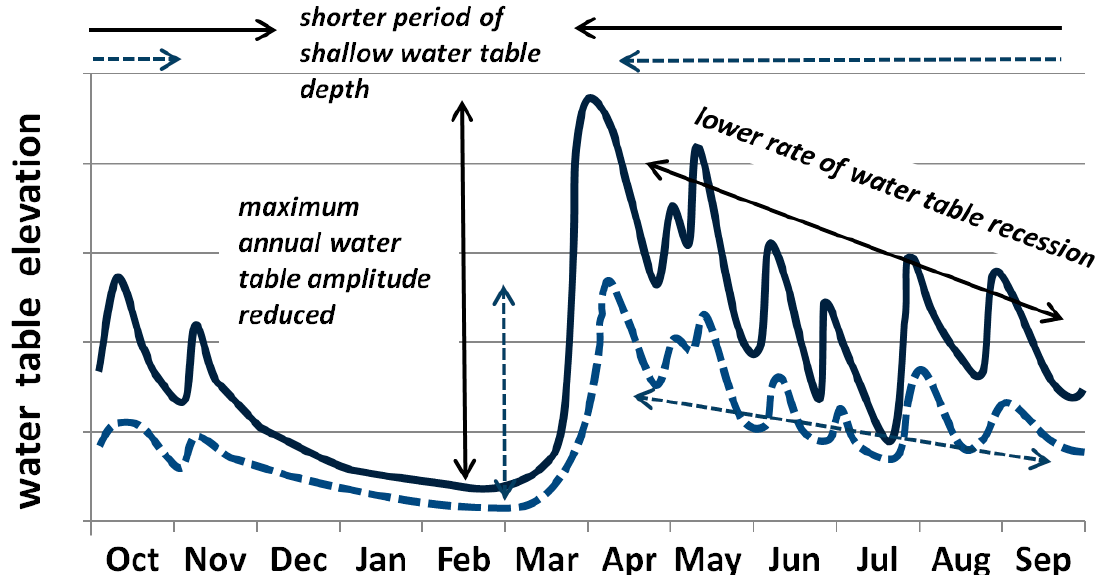
Figure 12. Schematic hydrograph showing the overall effect of incision on the annual groundwater levels of swale wetlands in the vicinity of Drain 10. Solid lines show reference seasonal water level variation and dashed lines show changes associated with incision. (Figure adapted from Gerla et al. [22]).